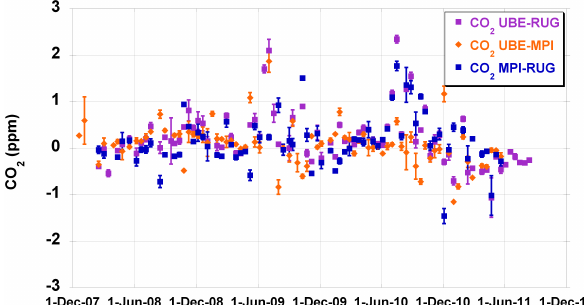
Fig. 3. Differences of the CO 2 concentration measured by each pair of two laboratories. The average differences are: 0.20ppm for UBE- RUG, 0.08ppm for UBE-MPI and 0.14ppm for MPI-RUG. The error bars represent the quadratically added standard errors of the measurements of the two